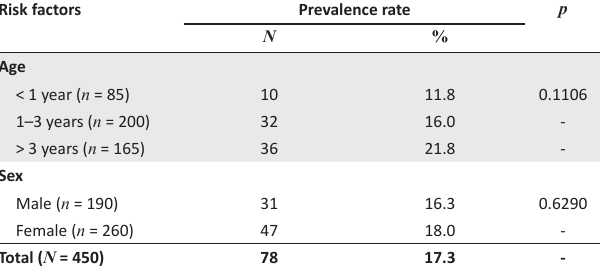
TABLE 1: Prevalence of lumpy skin disease in cattle according to age and sex. Risk factors Prevalence